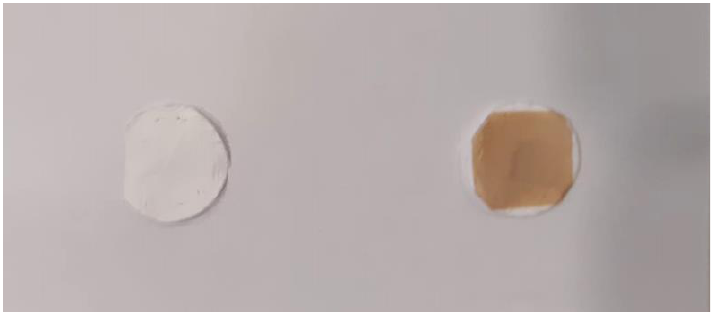
Figure 1. Picture of representative samples of electrospun blank PCL ( left ) and Ag-coated PCL ( right ).